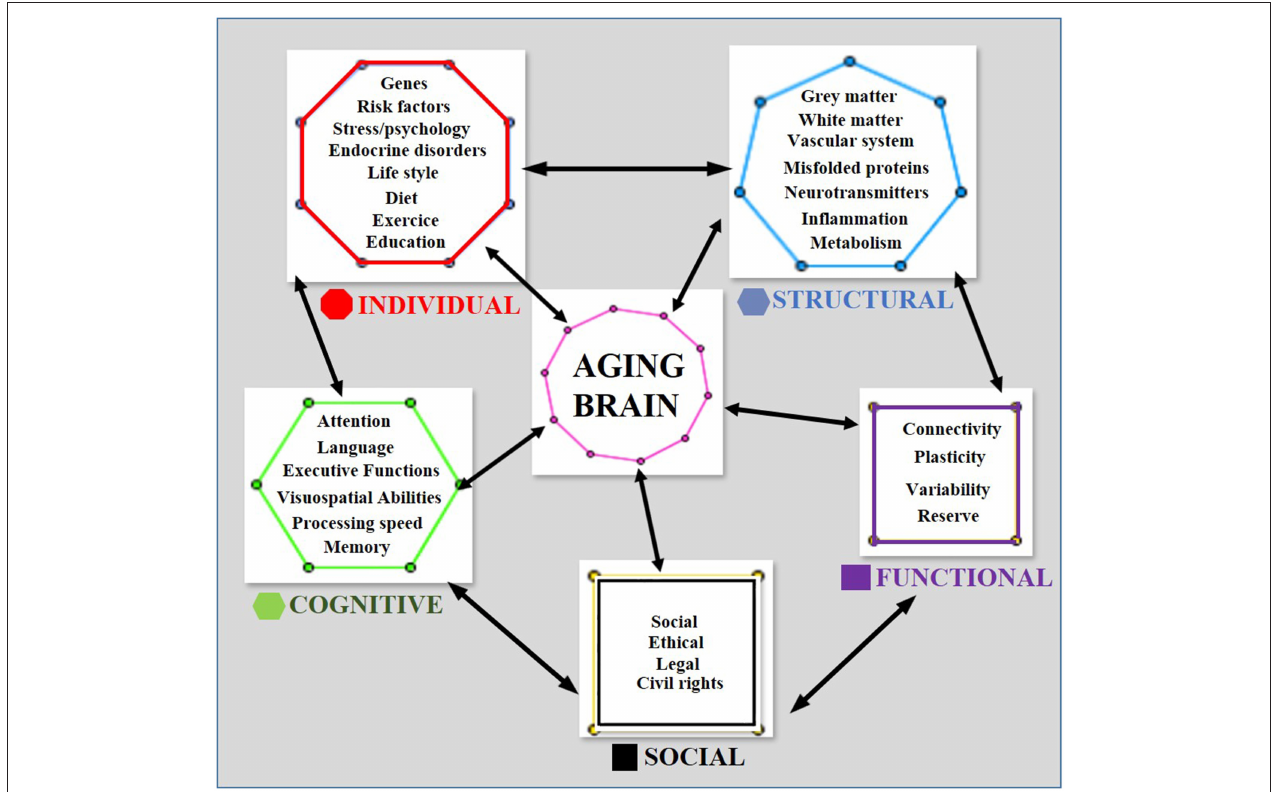
FIGURE 1 | A multidimensional geometric model of cognitive brain aging. Each geometric figure contains the set of factors that affect the multidimensional phenomenon of aging. The number of sides of each geometric figure corresponds to the number of factors contained in it, e.g., the hexagon contains the 6 main cognition factors. Bidirectional arrows indicate an effect of the factors upon each other and on the aging phenomenon.